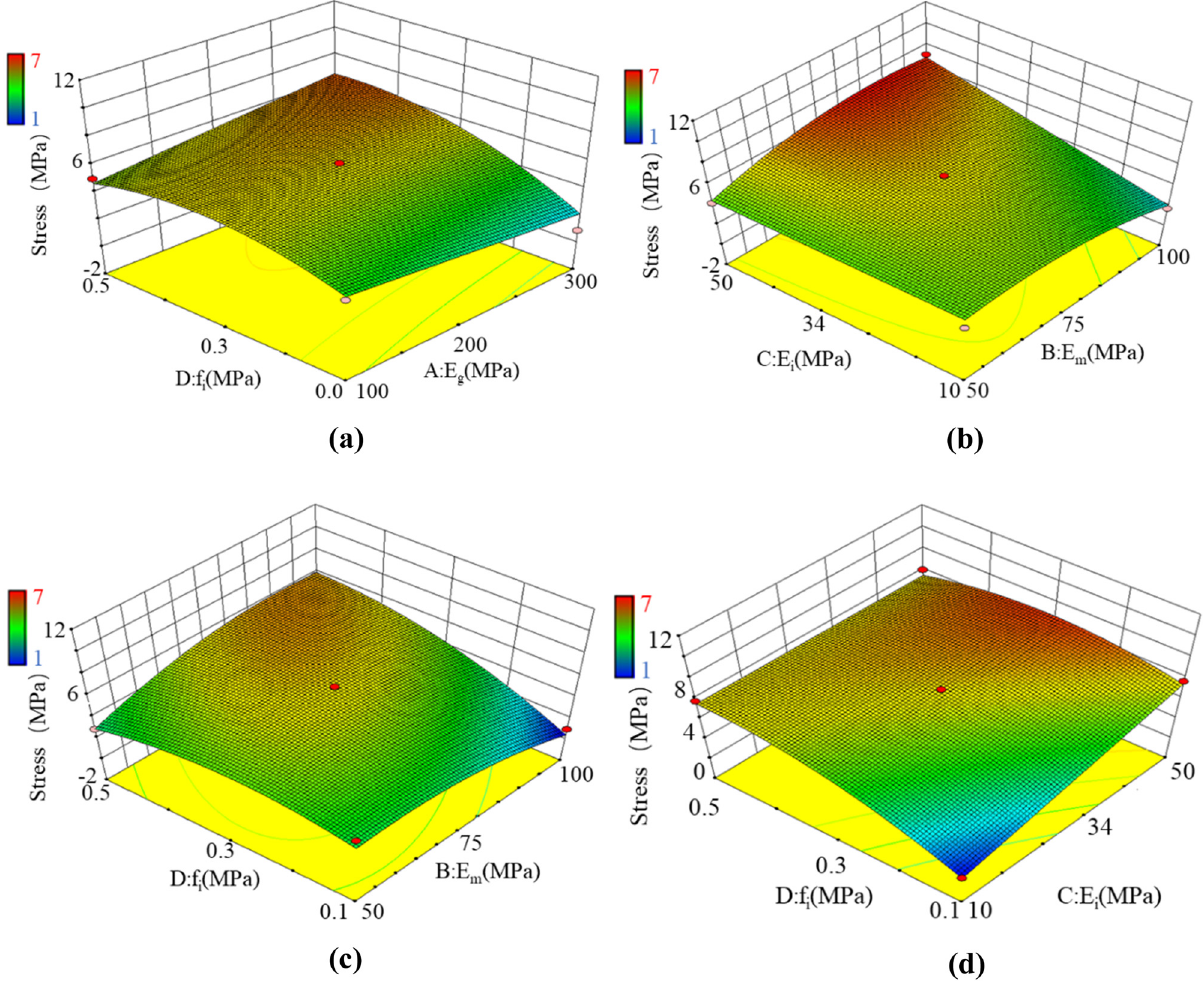
Figure 8: Comparative analysis of the in fl uence of interaction terms on σ max . ( a ) The in fl uence of AD interaction term on σ max . ( b ) The in fl uence of BC interaction term on σ max . ( c ) The in fl uence of BD interaction term on σ max . ( d ) The in fl uence of CD interaction term on σ max .